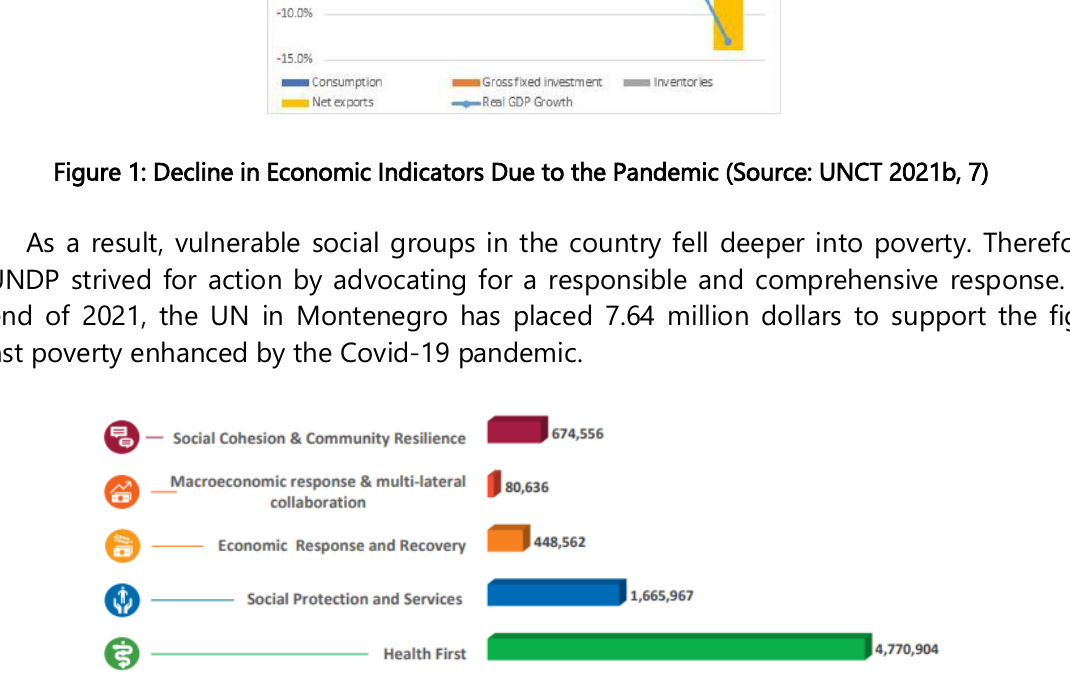
Figure 2: UN Socio-Economic Response to the Covid-19 Pandemic (Source: UNCT